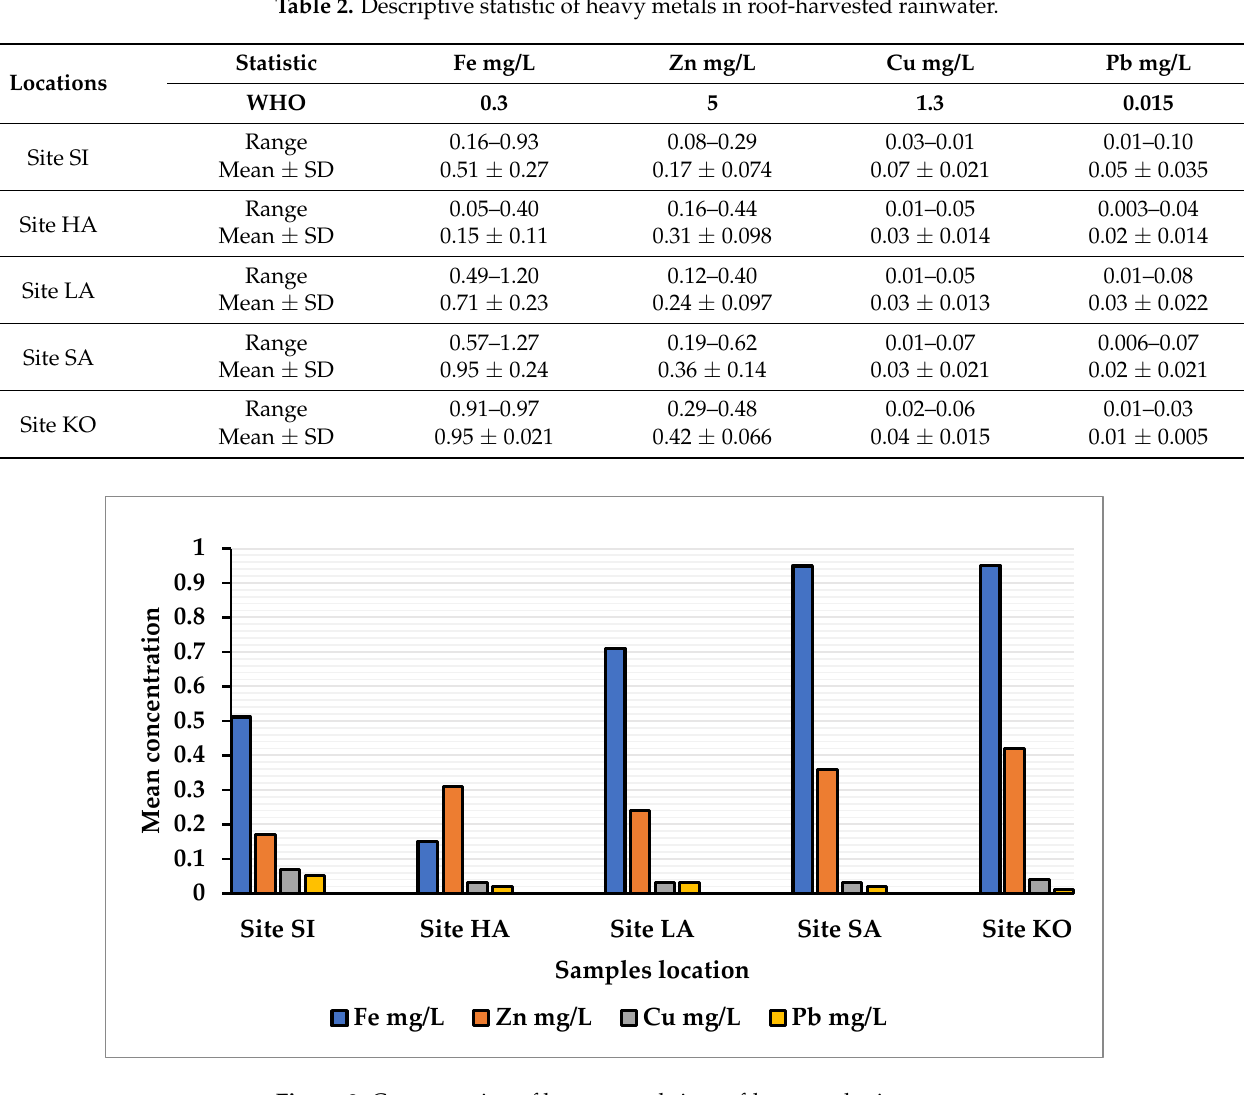
Figure 3. Concentration of heavy metals in roof-harvested rainwater.